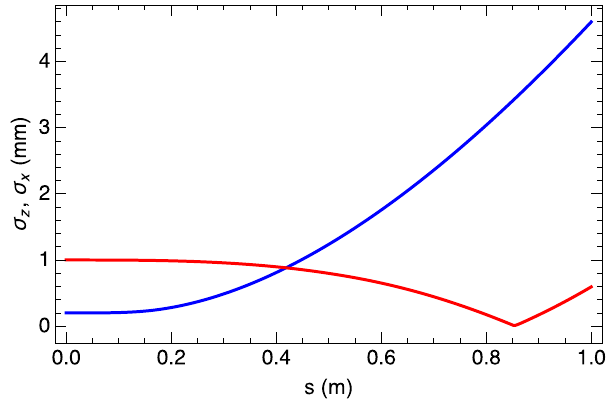
FIG. 2. Plot of the rms longitudinal (red) and horizontal (blue) bunch lengths as functions of arc length s